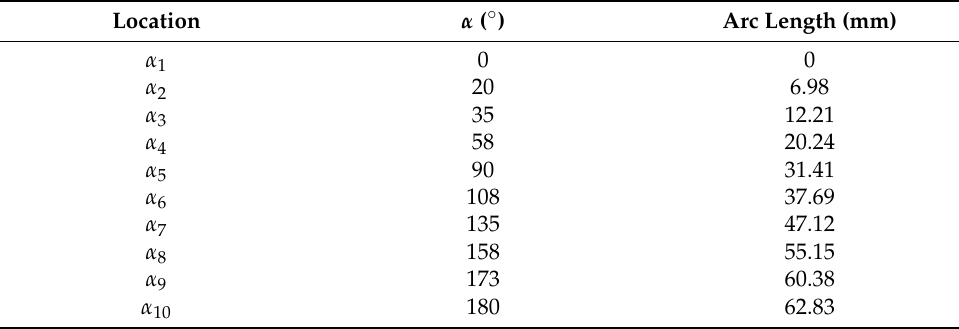
Figure 5. Geometrical dimensions of the specimens for: ( a ) Tensile test; ( b ) Flexural test. Table 1. Locations for transformation along the arc length of the